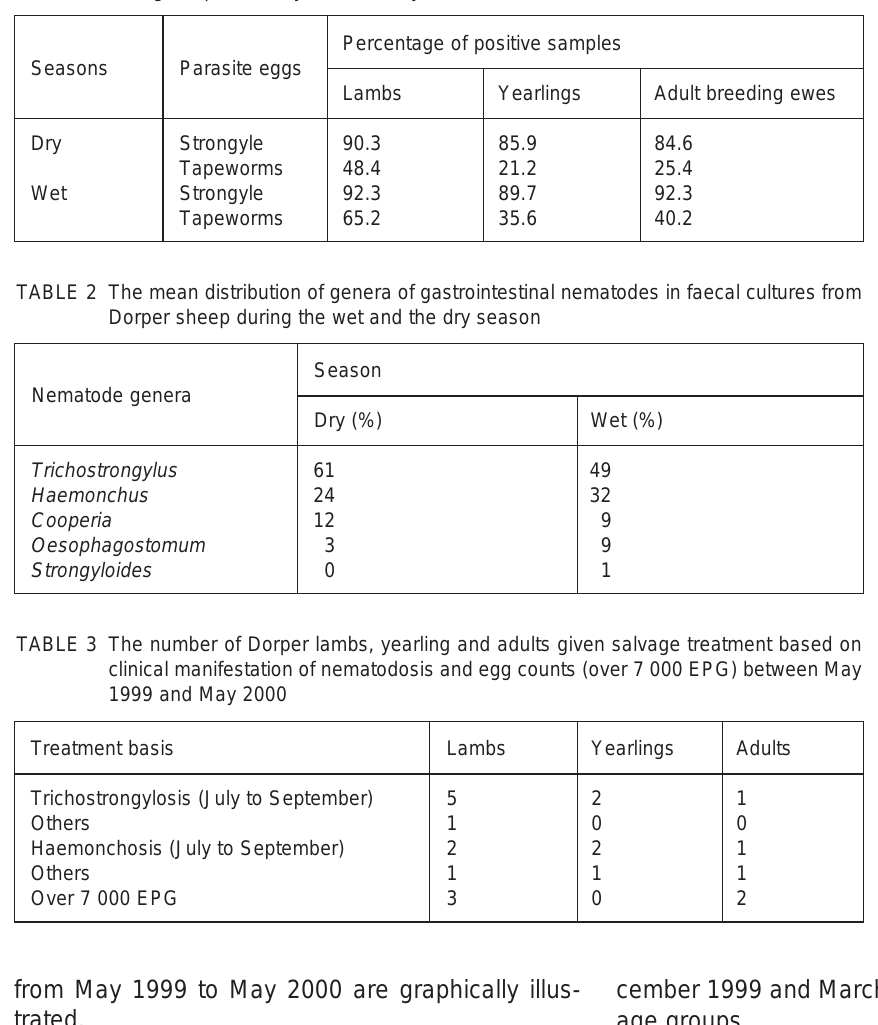
TABLE 1 The proportion of faecal samples for Dorper lambs, yearlings and breeding ewes that were found to be positive for strongyle and tapeworm eggs in Kajiado District of Kenya